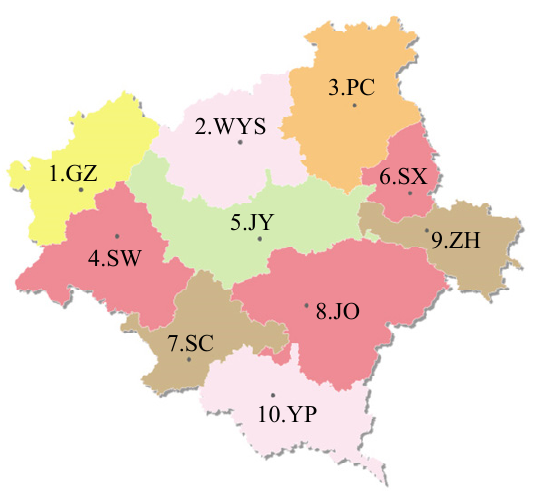
Figure 3. Distribution of data sources of regional power grid.